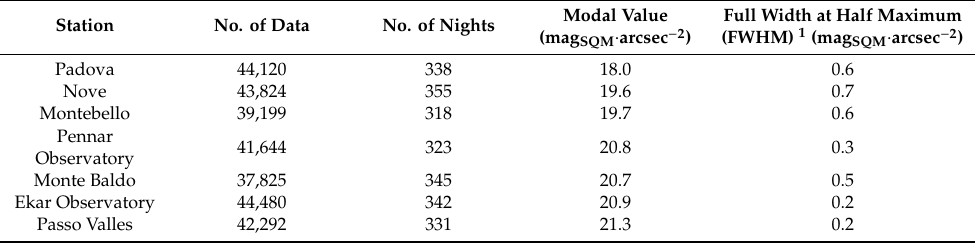
Table 2. Data information and statistics night sky brightness (NSB) values.